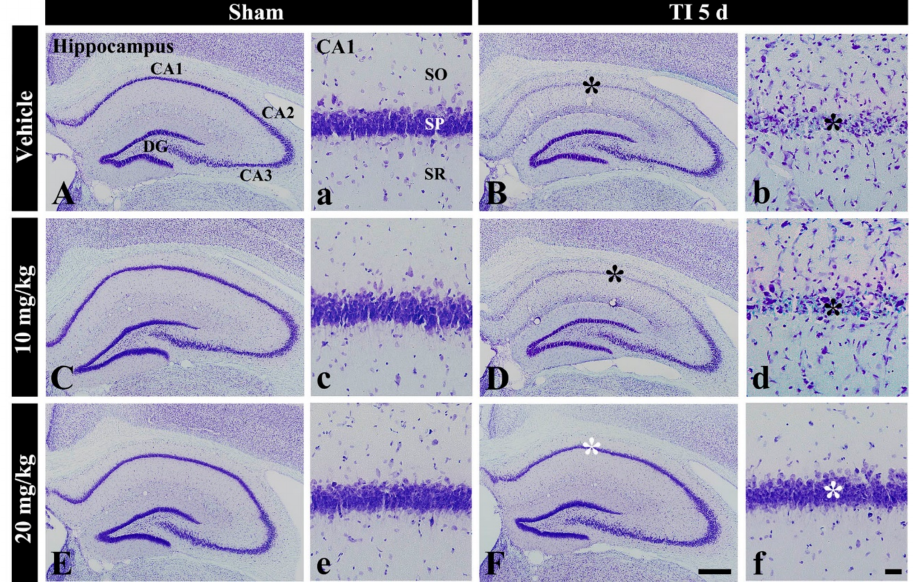
Figure 1. CV staining in the hippocampus of the vehicle-sham ( A , a ), vehicle-TI ( B , b ), 10 mg/kg salicin-sham ( C , c ), 10 mg/kg salicin-TI ( D , d ), 20 mg/kg salicin-sham ( E , e ), and 20 mg/kg salicin-TI ( F , f ) groups at 5 days post-TI. In the vehicle-TI and 10 mg/kg salicin-TI groups, CV stainability in the stratum pyramidale (SP, black asterisks) of CA1 is very pale. However, in the 20 mg/kg salicin-TI group, strong CV stainability is observed in the SP (white asterisks) ( n = 5/group; the vehicle-sham group was regarded as control group). DG, dentate gyrus. SO, stratum oriens; SR, stratum radiatum. Scale bar = 400 µ m ( A – F ) and 50 µ m ( a – f